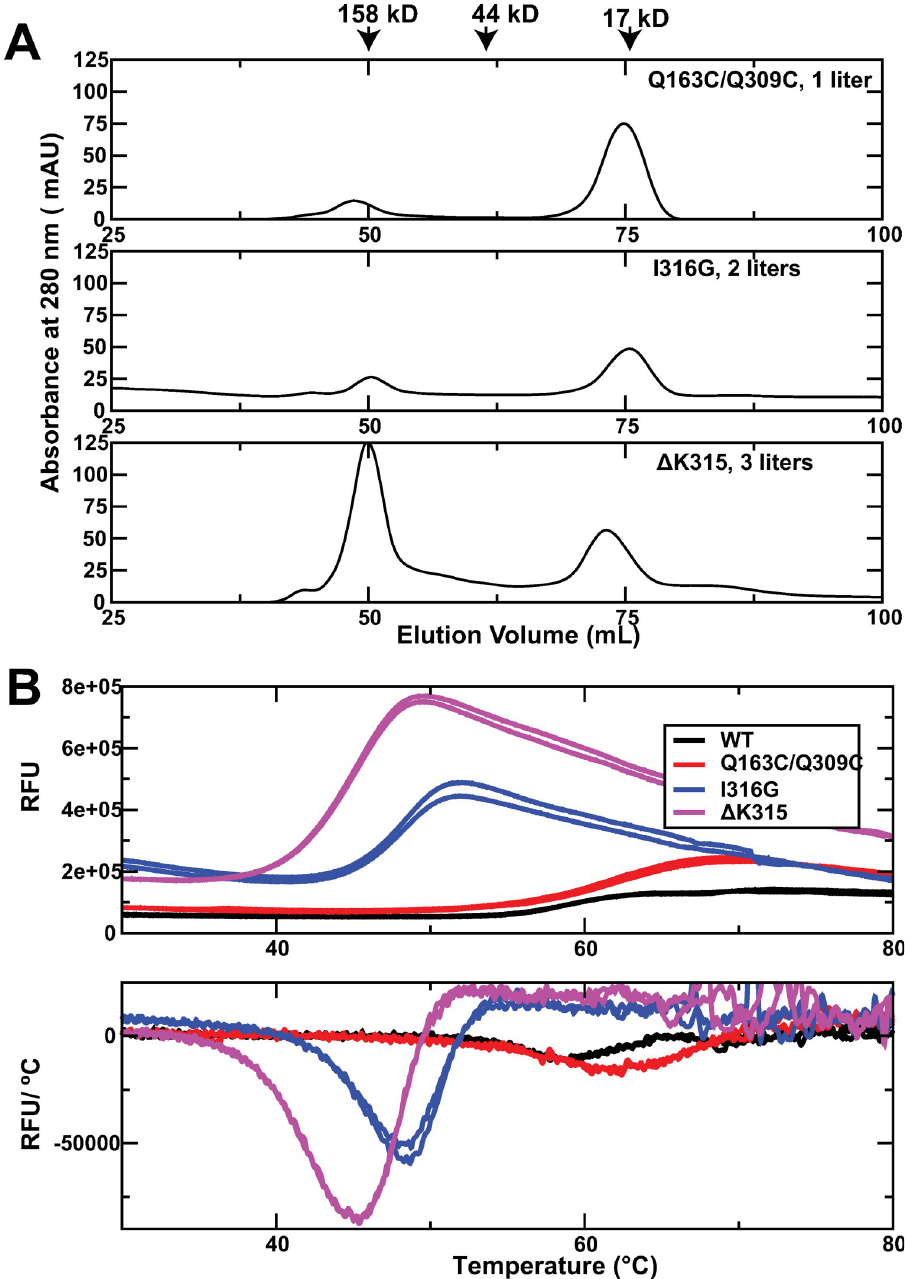
Fig 2. Comparison of the yield and stability of the active mutants. A) The final SEC chromatograms of the three active mutants. The chromatograms are proteins from 1 liter of the Q163C/Q309C mutant, 2 liters of the I316G mutant, and 3 liters of the Δ K315 mutant. B) Fluorescence changes in the thermal shift assay of the active mutants. The top panel is the plot of the fluorescence signal against the temperature. The bottom panel is the plot of the derivative of the fluorescence signal with respect to the